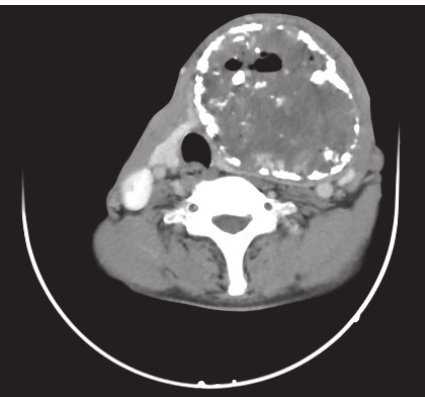
Figure 1: Computed tomography revealing enlarged left thyroid lobe with heterogeneous enhancement and calcifications. There was a hypodense component with focal air loculi within the lesion.